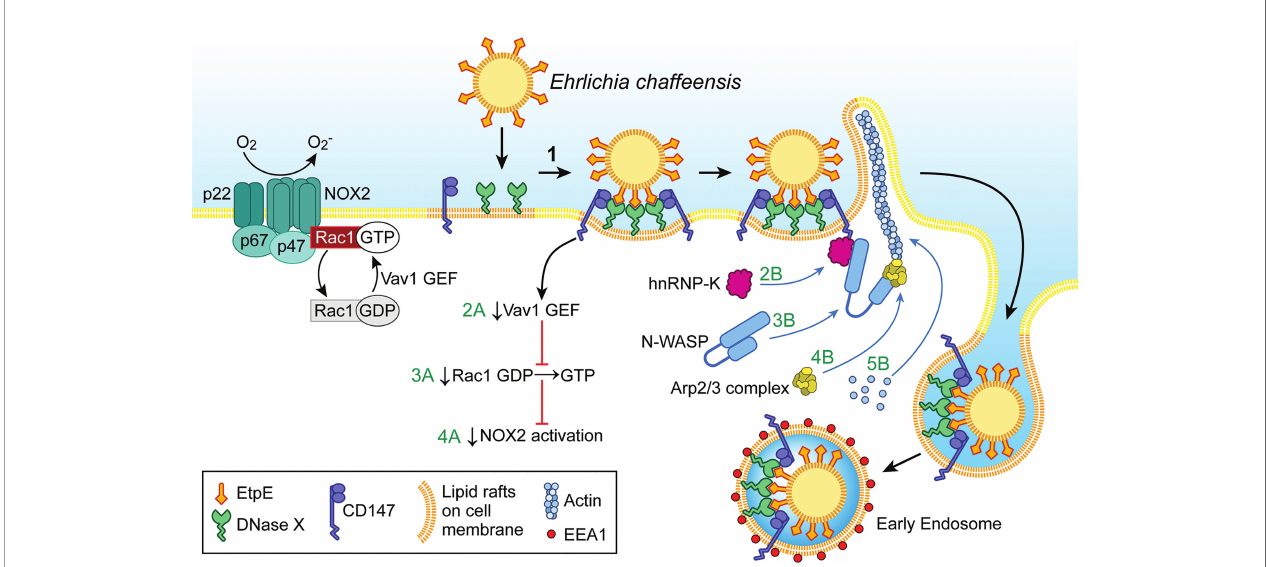
FIGURE 1 | Ehrlichia entry is coupled with blockade of the activation of the phagocyte NADPH oxidase (NOX2) complex. Extracellular E. chaffeensis uses the C- terminal region of its surface protein EtpE to bind DNase X on the host-cell surface. The consequent lateral redistribution of DNase X within dynamic lipid rafts brings CD147 into association with the EtpE – DNase X complex (1). CD147 relays the signal to downregulate Vav1 GEF (guanine-nucleotide exchange factor; 2A) that prevents Rac1 activation (3A) and consequently prevents activation of the NOX2 complex (4A). CD147 also recruits hnRNP-K to bind N-WASP, leading to activation of N-WASP (conformational change) (2B and 3B). Activated N-WASP binds the Arp2/3 actin-nucleation complex (4B), leading to spatiotemporal actin polymerization and fi lopodia formation to internalize E. chaffeensis into endosomes (5B). The drawing was modi fi ed from (Mohan Kumar et al., 2015), copyright 2015